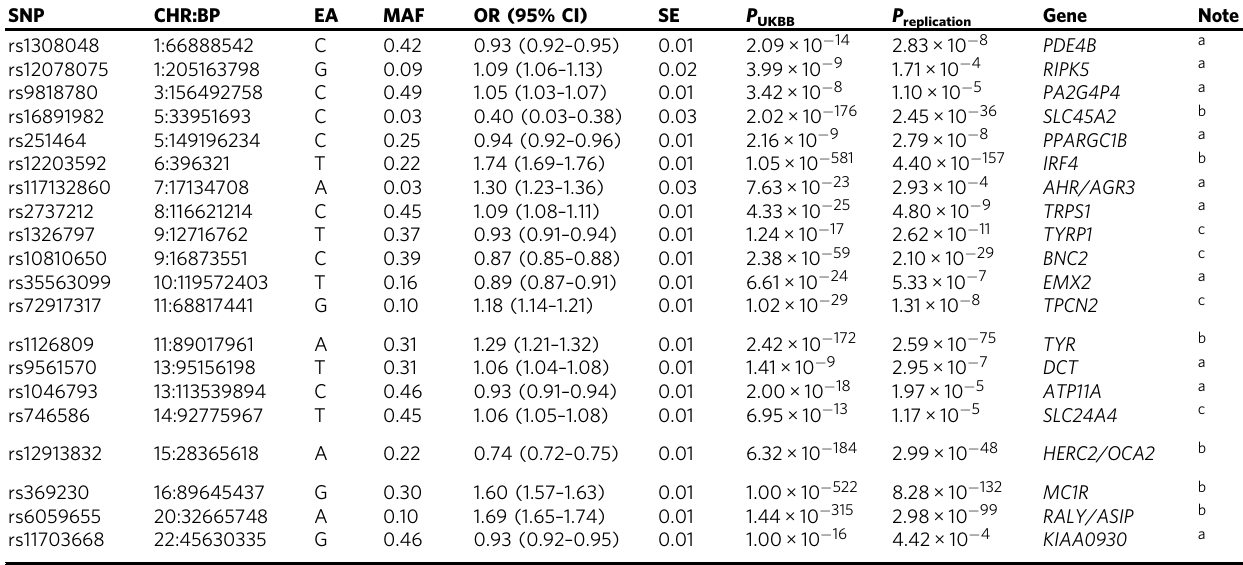
Table 1 Genome-wide association and replication for ease of skin tanning